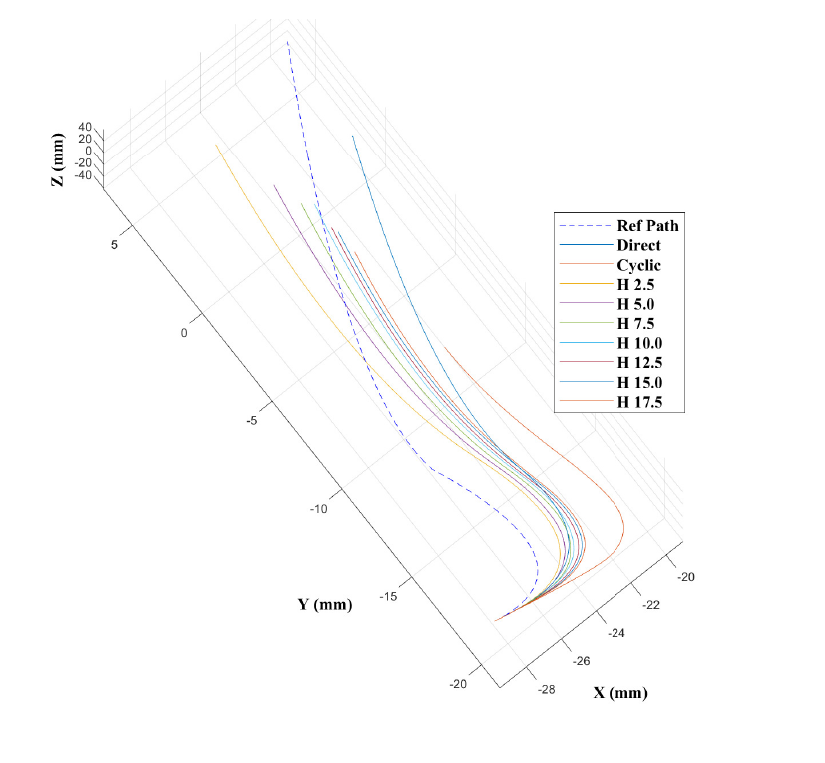
Figure 8. Catheter trajectories for the single bend path.